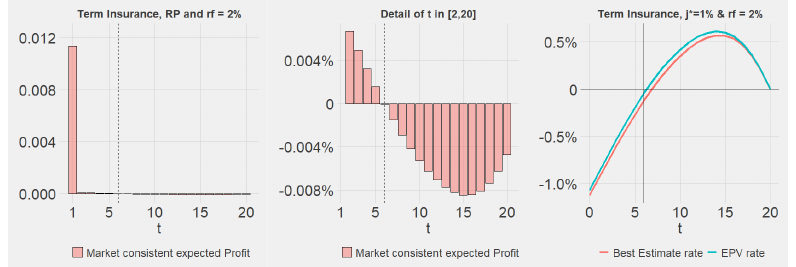
Figure 5. Expected demographic profit in the Term Insurance with higher risk-free